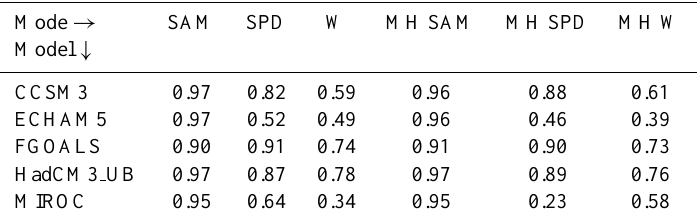
Table 2. Spatial correlation coefficients for each of the PMIP2 models used in this analysis and the 1971–2000 NCEP data. Columns 2–4 (5–7) are the correlation coefficients between the NCEP data and the control (Mid-Holocene, MH)